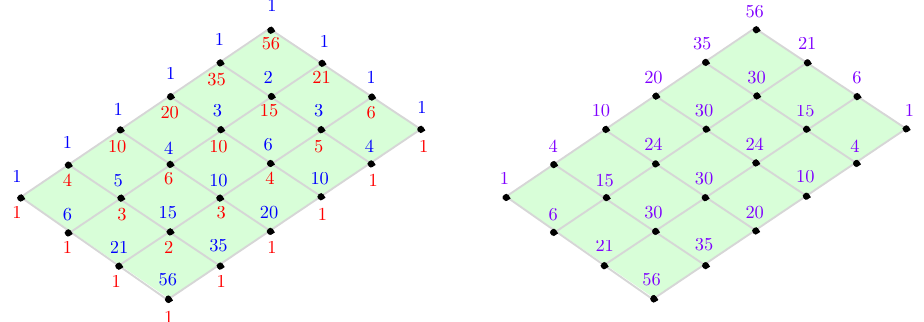
paths ( a , b ) in red, # ↑